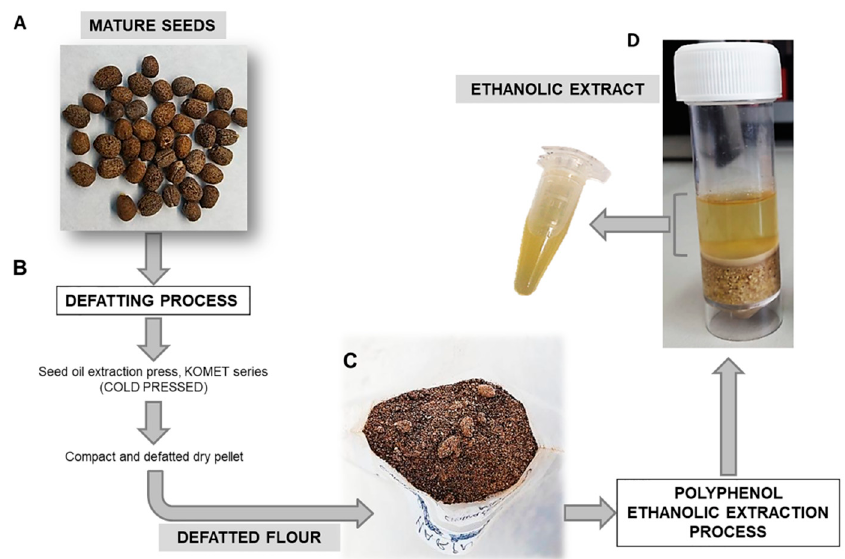
Figure 1. Representative image of ethanolic extracts obtained from Euphorbia lathyris . ( A ) Euphorbia lathyris mature seeds; ( B ) Schematic representation of the defatting process from mature seeds; ( C ) Macroscopic image of defatted flour from mature seeds; ( D ) Macroscopic image of the polyphenol ethanolic extraction process and the final extract obtained.